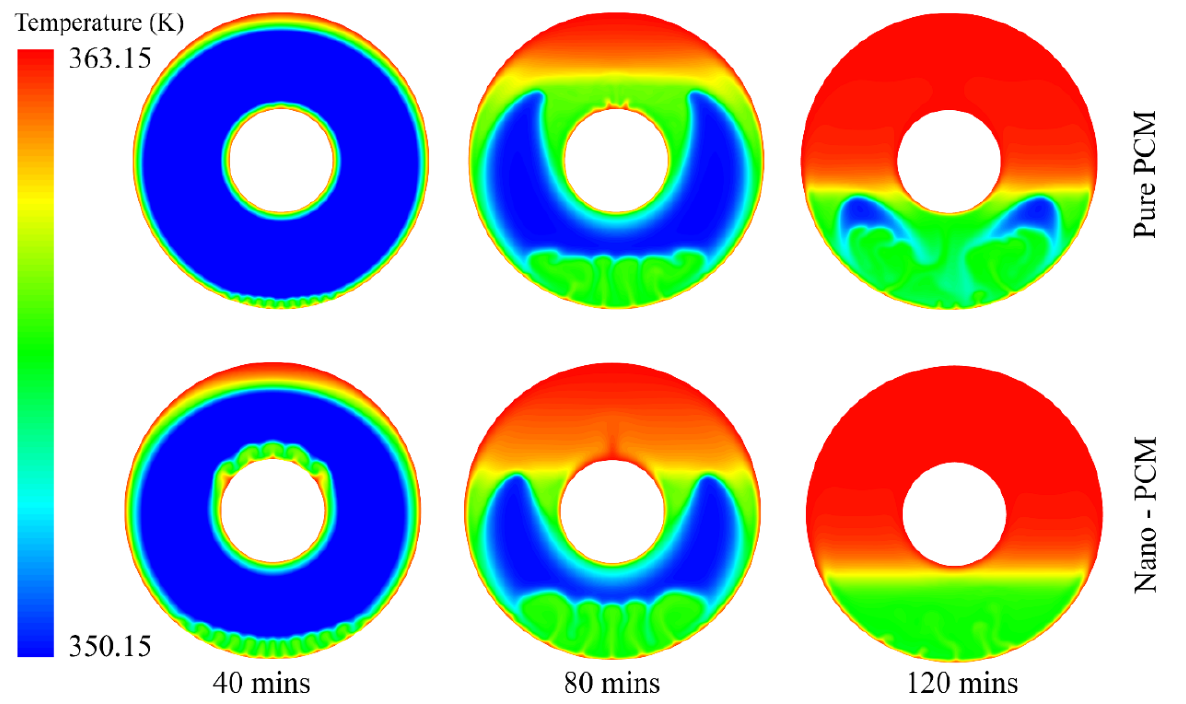
Figure 9. Temperature distribution of PCM during the melting processes with and without nano- particles.